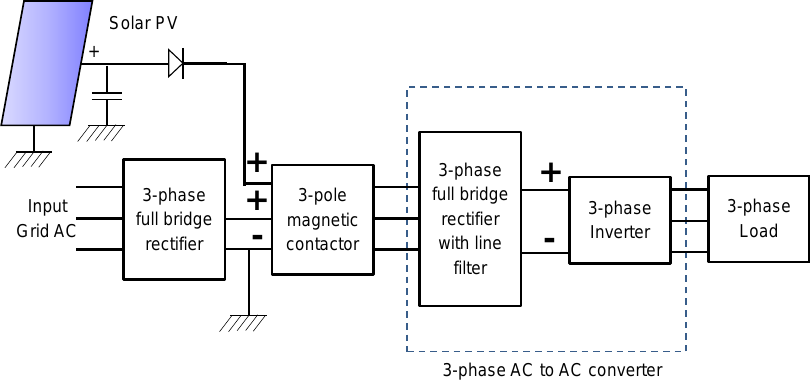
Figure 1. Block diagram of the control circuit to drive the existing motor